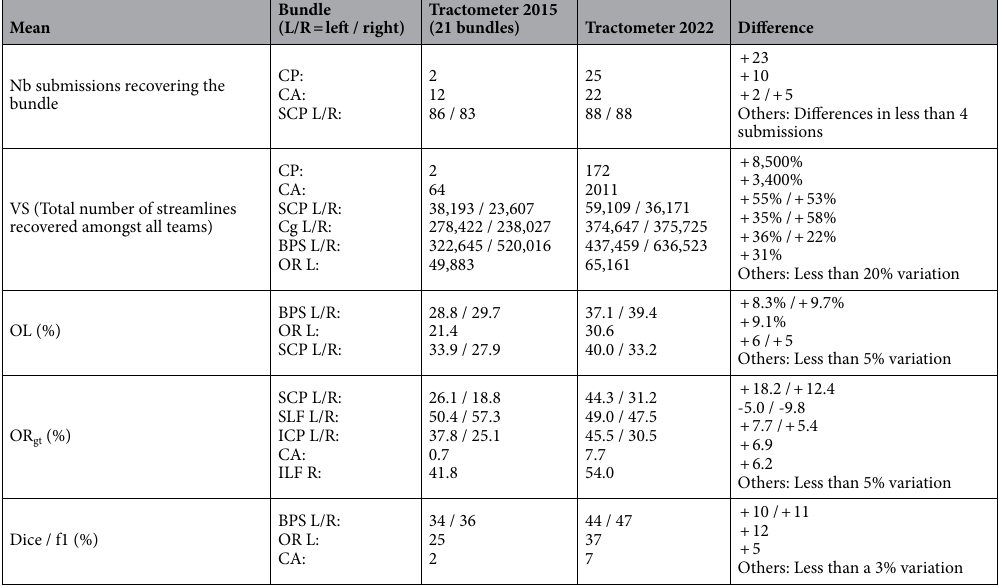
Tractometer 2015 (21 bundles) Tractometer 2022